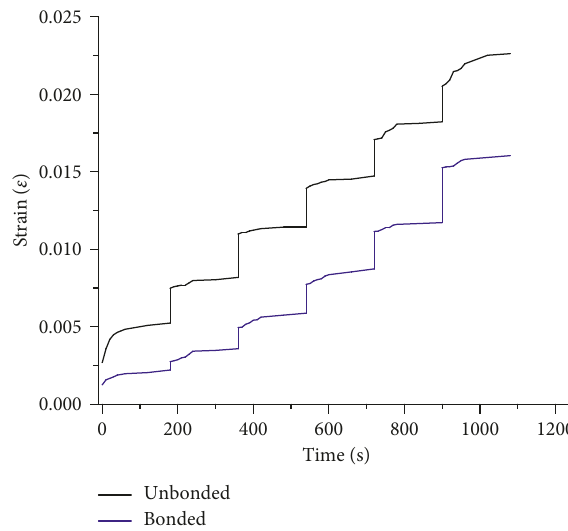
Figure 9: Time history of vertical strains of the bonded and unbonded samples.